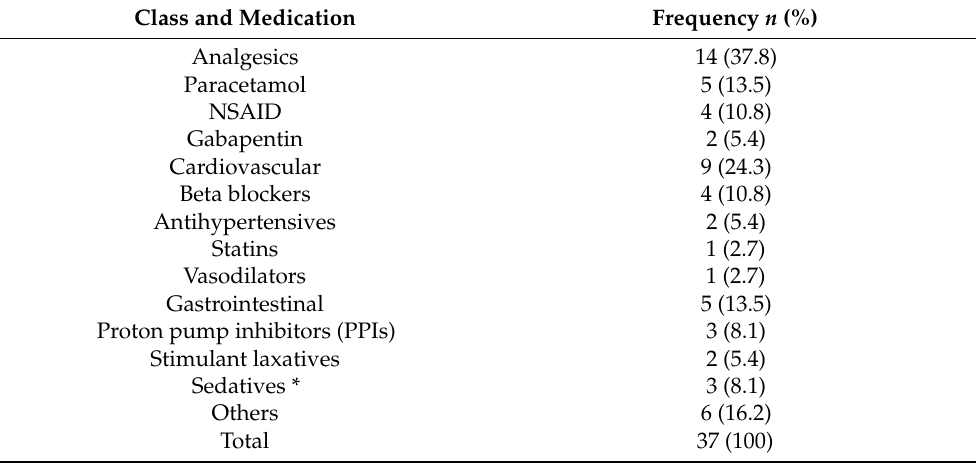
Table 3. Most frequently deprescribed medications in the intervention